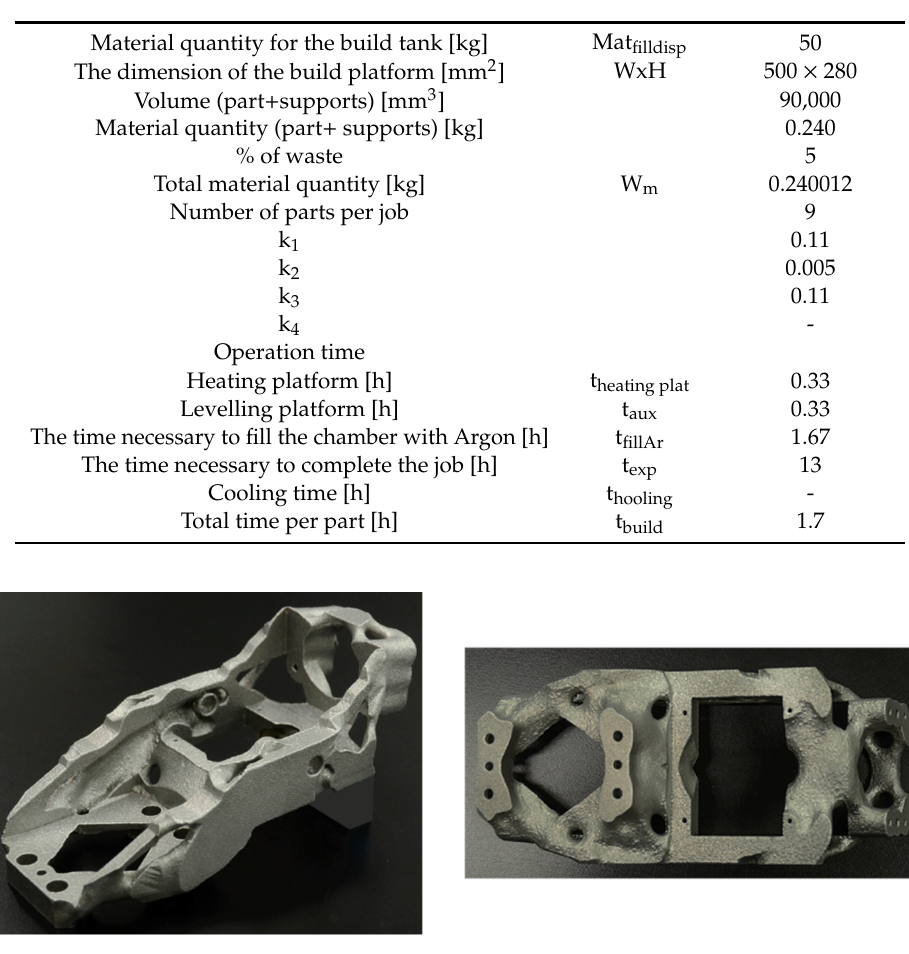
Figure 12. Part manufactured by SLM500. The idle times (Table 3) have been measured during the